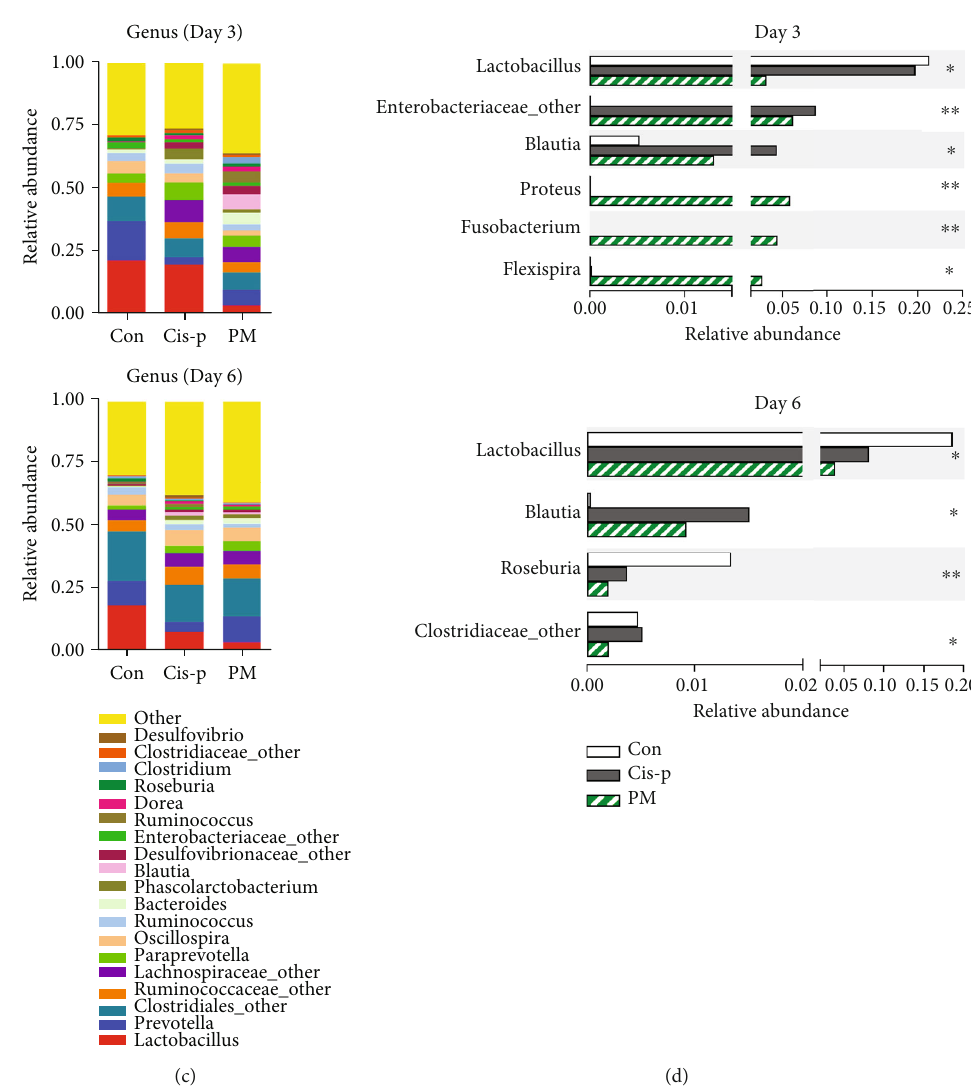
Figure 4: Probiotic mixture modulated intestinal bacterial composition in cisplatin-treated rats ( n = 4 -5). (a) Principal component analysis (PCA) among di ff erent samples. (b) Mean abundances in the gut microbiota at the phylum level. (c) Bar charts of the gut microbiota at the genus level. (d) Species di ff erences among the three groups at the genus level. ∗ p < 0 : 05 and ∗∗ p < 0 : 01